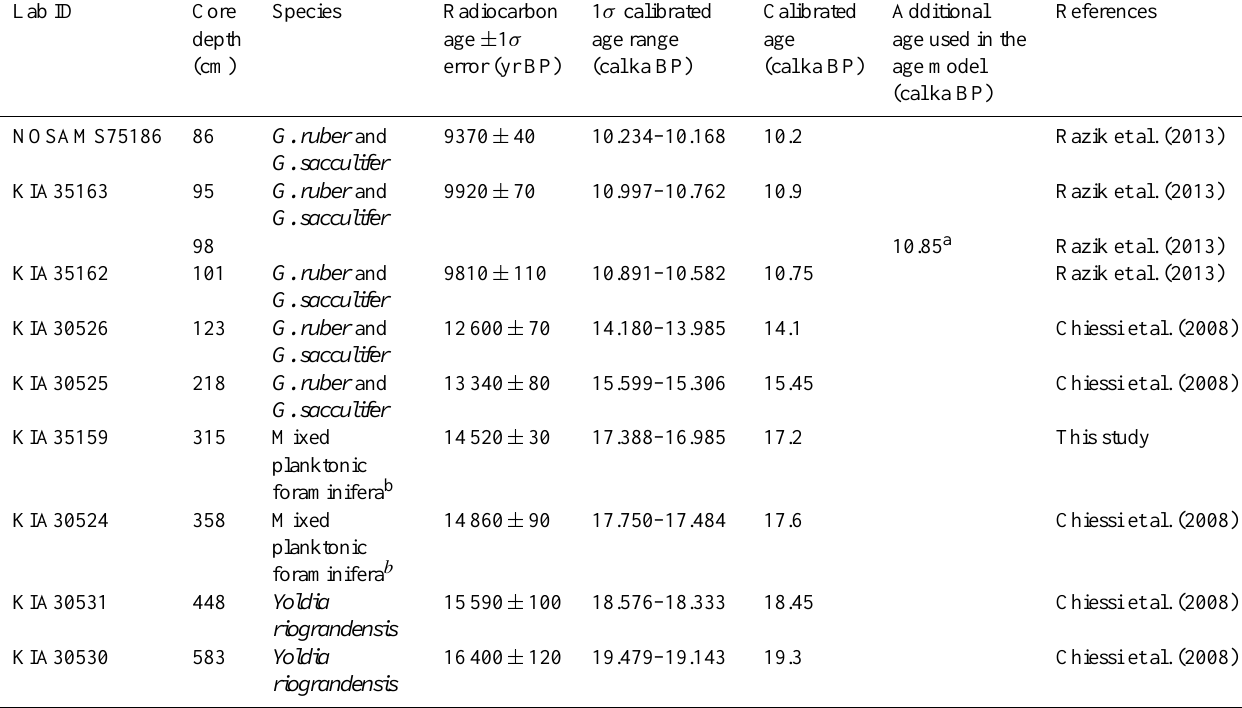
Table 1. Accelerator mass spectrometer radiocarbon ages and calibrated ages used to construct the age model of core GeoB6211-2. Lab